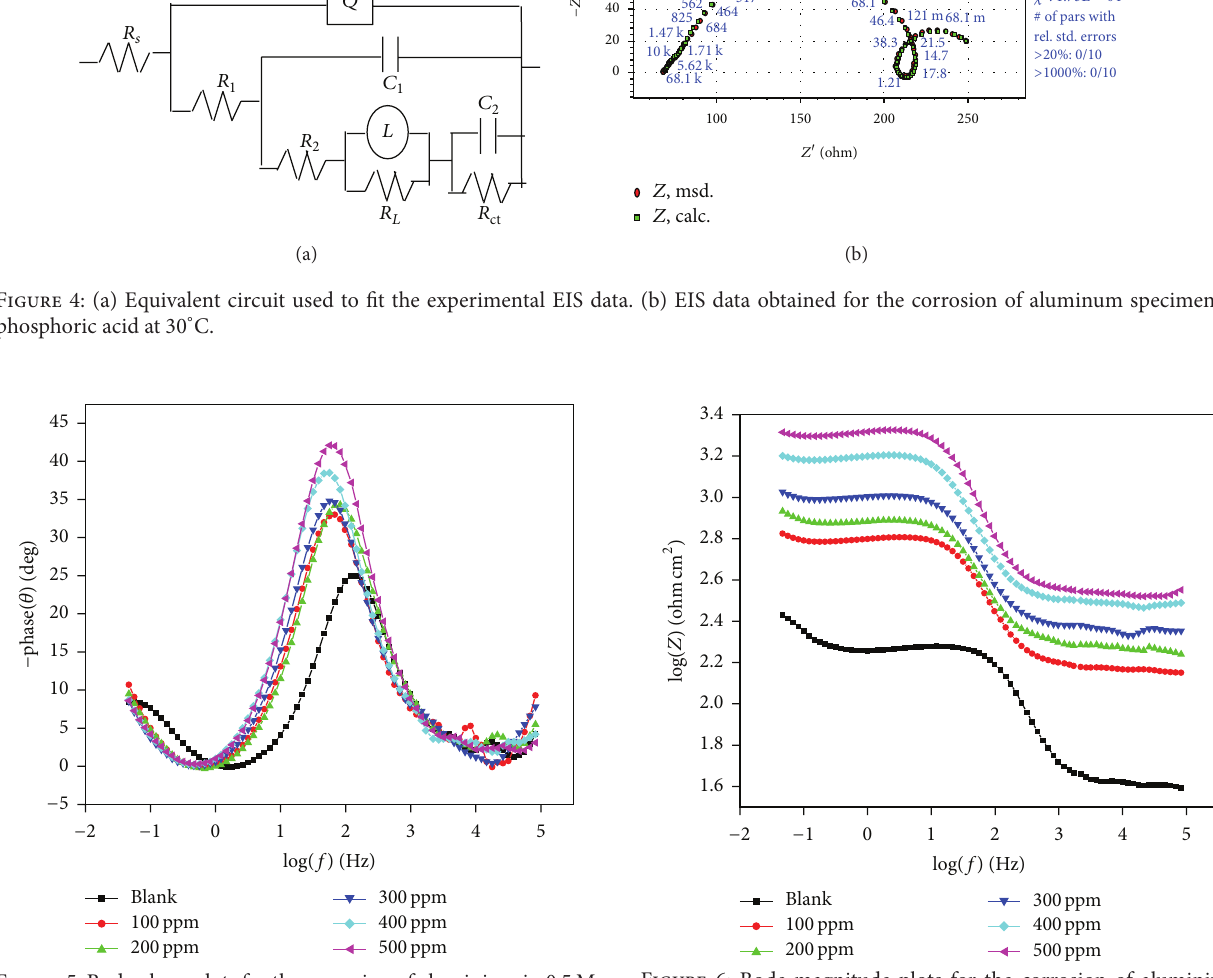
Figure 5: Bode phase plots for the corrosion of aluminium in 0.5 M phosphoric acid at 30 ∘ C in the presence of different concentrations of GIE.